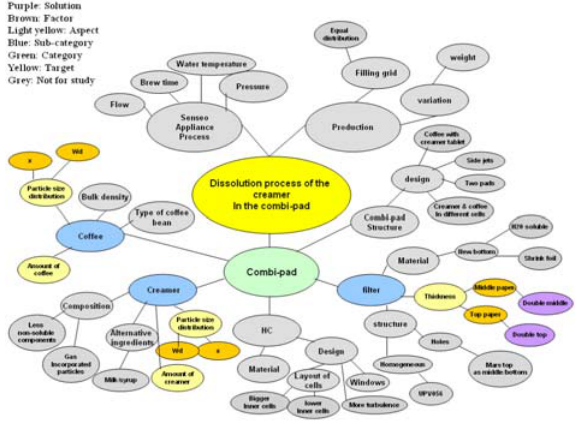
Fig. 6. Simulation result from the programmed model.